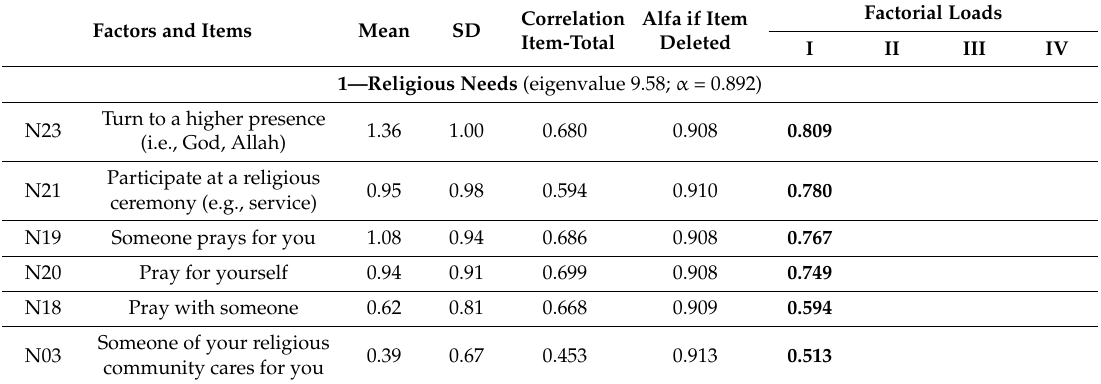
Table 3. Factorial structure, means and standard deviations of the SpNQ—Portuguese Version in a structure of five